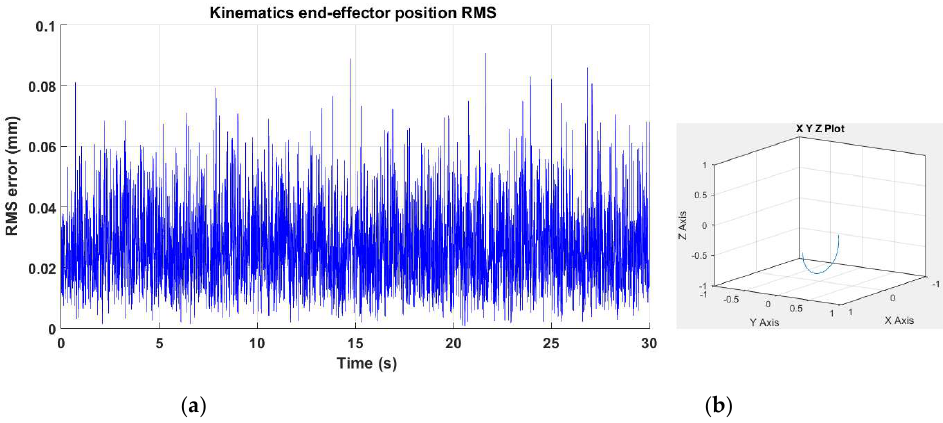
Figure 23. Power of proposed fault-tolerant algorithm for ( a ) kinematics end-effector position RMS error and ( b ) end effector position in the XYZ plot.